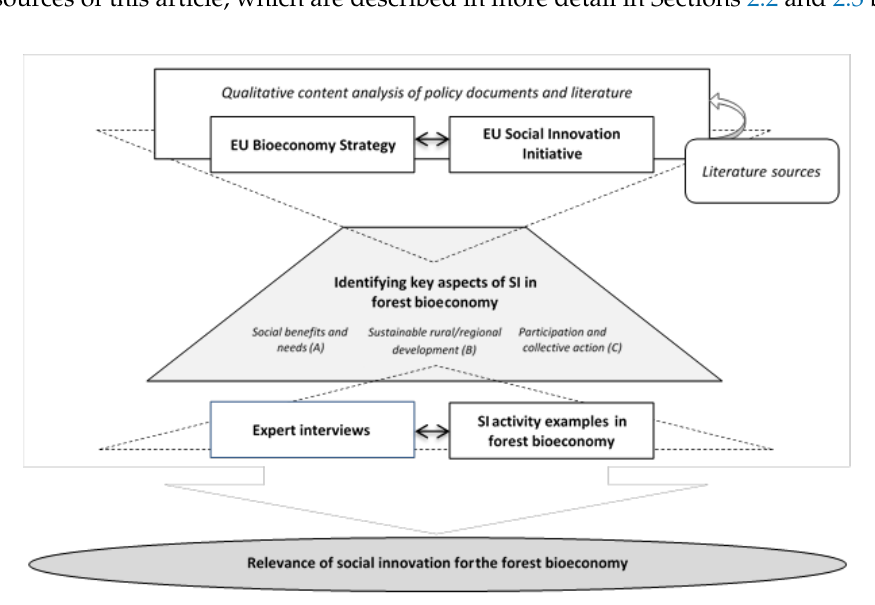
Figure 2. Conceptual and methodological approach.